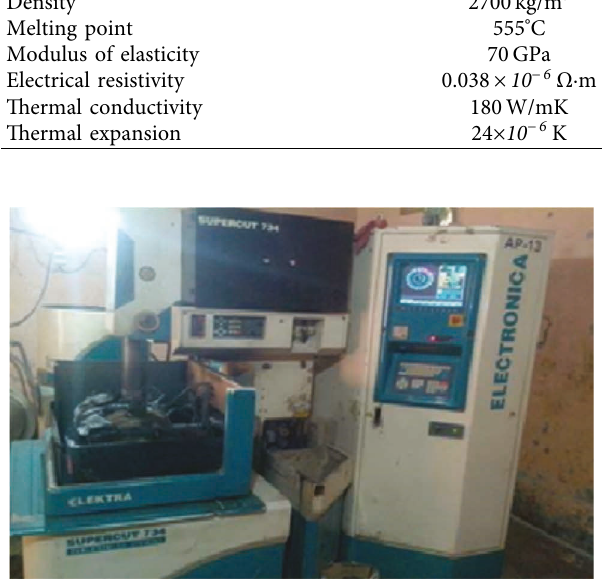
Figure 2: WEDM CNC machine.